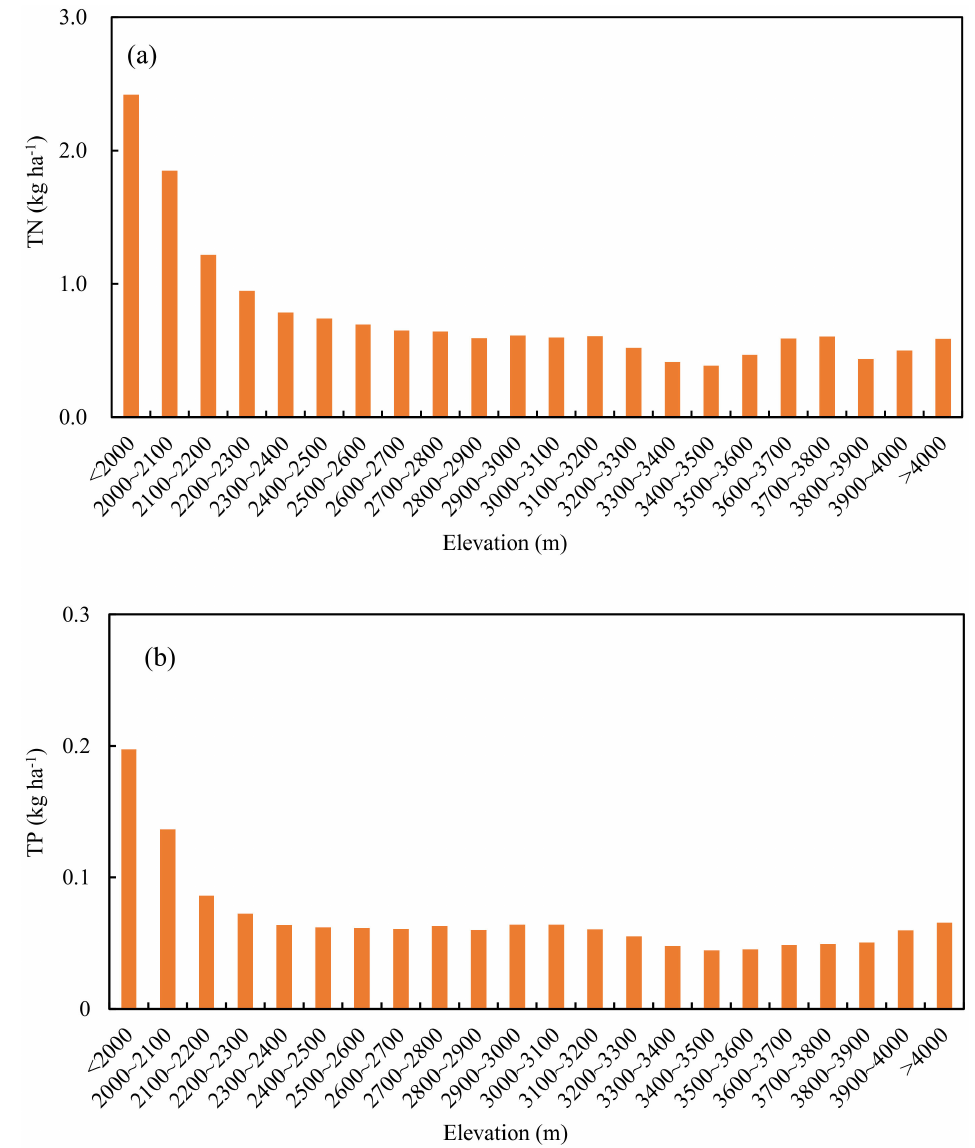
Figure 13. Intensity of TN ( a ) and TP ( b ) pollution load at different elevations in Lake Erhai water-